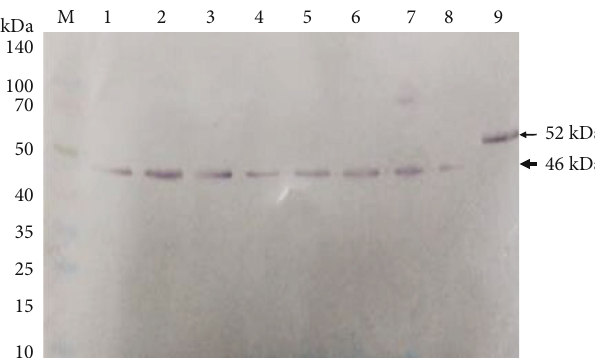
Figure 7: Antibodies anti-rNTHiENO recognize to native enolase of H. in fl uenzae typeable and nontypeable. Immunodetection by western blot of the native enolase of H. in fl uenzae using anti- rNTHiENO polyclonal antibodies. Lane M: prestained protein marker. Lanes 1-4: total protein extracts of HibBUAPNAN, HibATCC33, HiNTBUAP96, and HiNTBUAPPAU, respectively. Lanes 5-8: enriched membrane proteins, same order. Lane